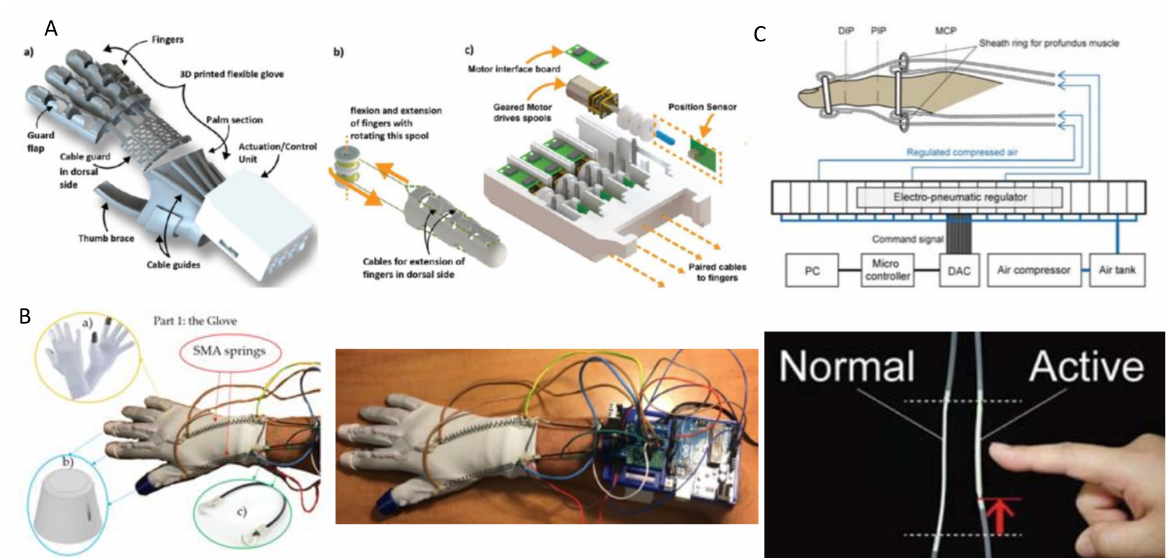
Figure 33. Soft glove actuation solutions. ( A ) Wire based actuation of the proposed by Mohammadi